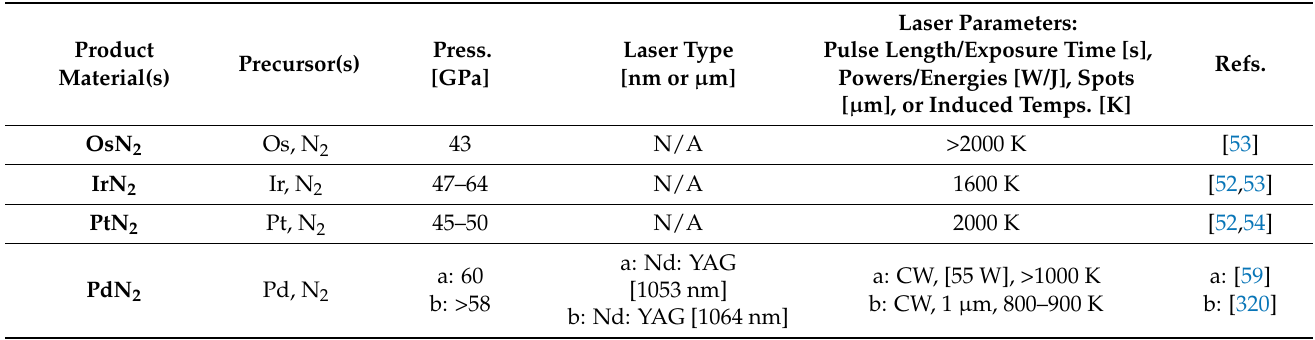
Table 8. Platinum-Group Metal Nitrides: Platinum-Group Metal Nitrides Synthesised During Selected LRS-DAC